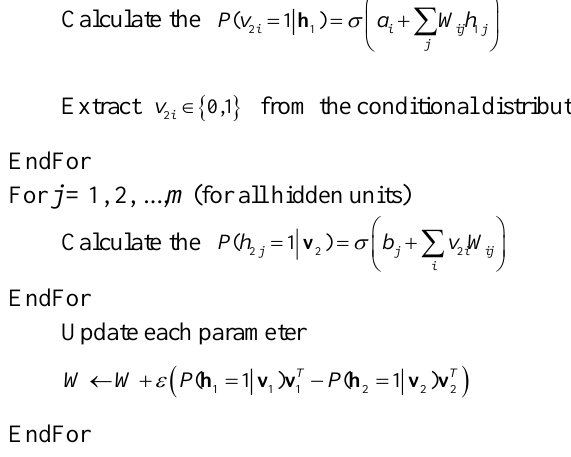
Figure 3. The training process of contrastive divergence (CD).